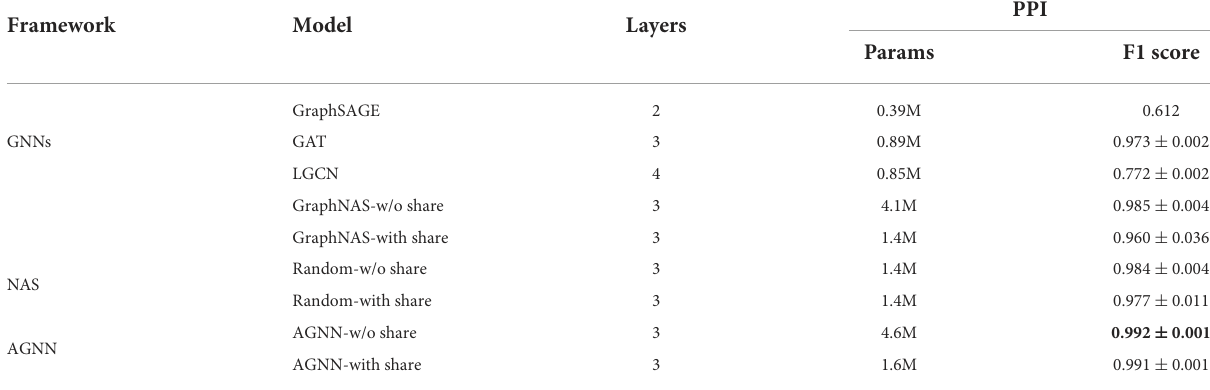
TABLE 2 Test accuracy of the human-invented and searched architectures under the inductive